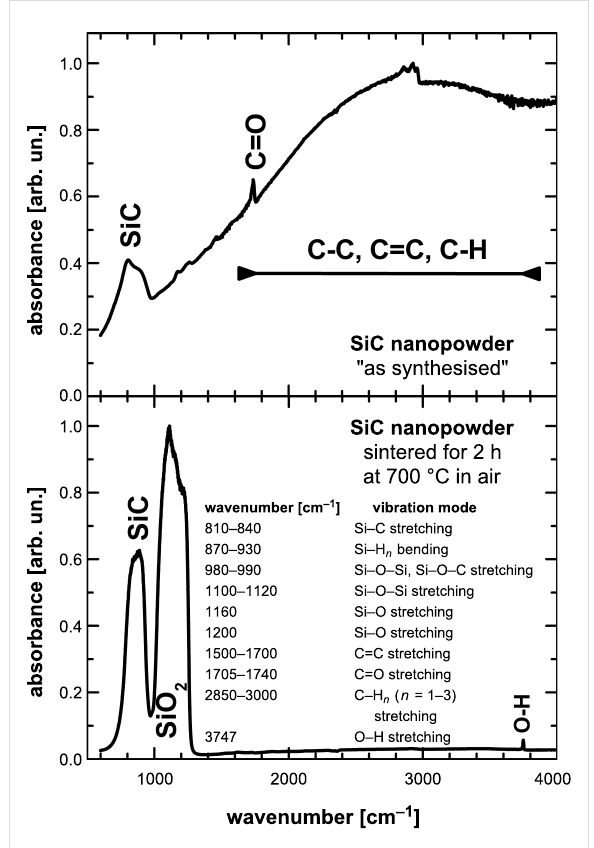
Figure 4: Infrared spectra of the sample number VII in Table 2, as synthesized and after calcinations in air at 700 °C. The thermal treat- ment changes the material colour from black to light grey. In the IR measurement carbon related signals disappear, while SiO 2 modes show